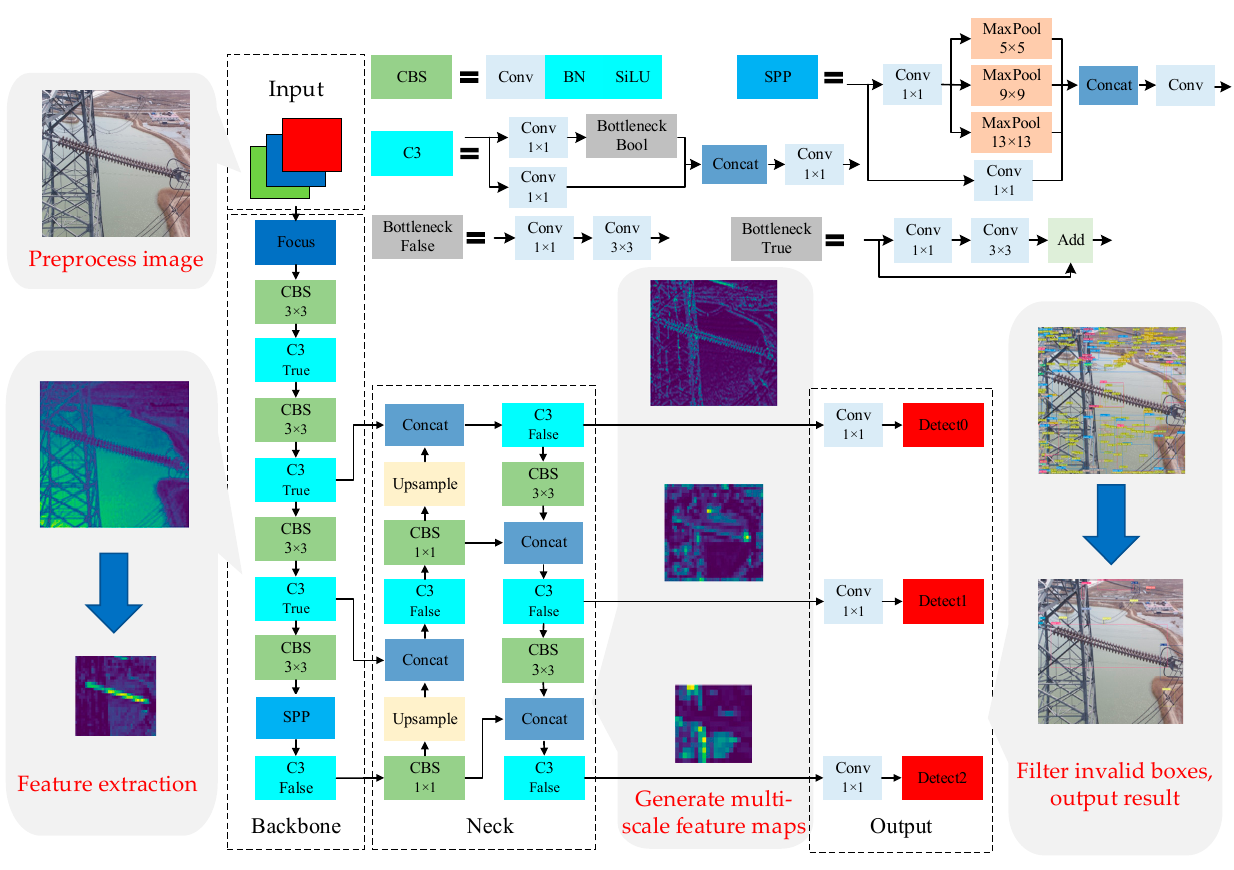
Figure 1. YOLOv5s